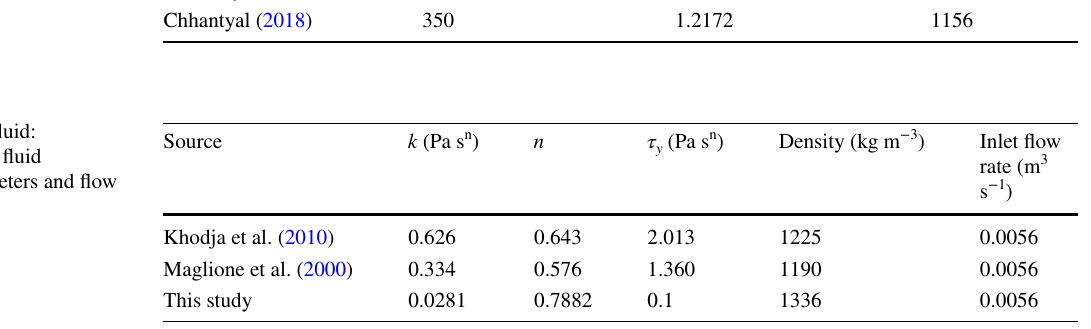
in the simulations: model drilling fluids